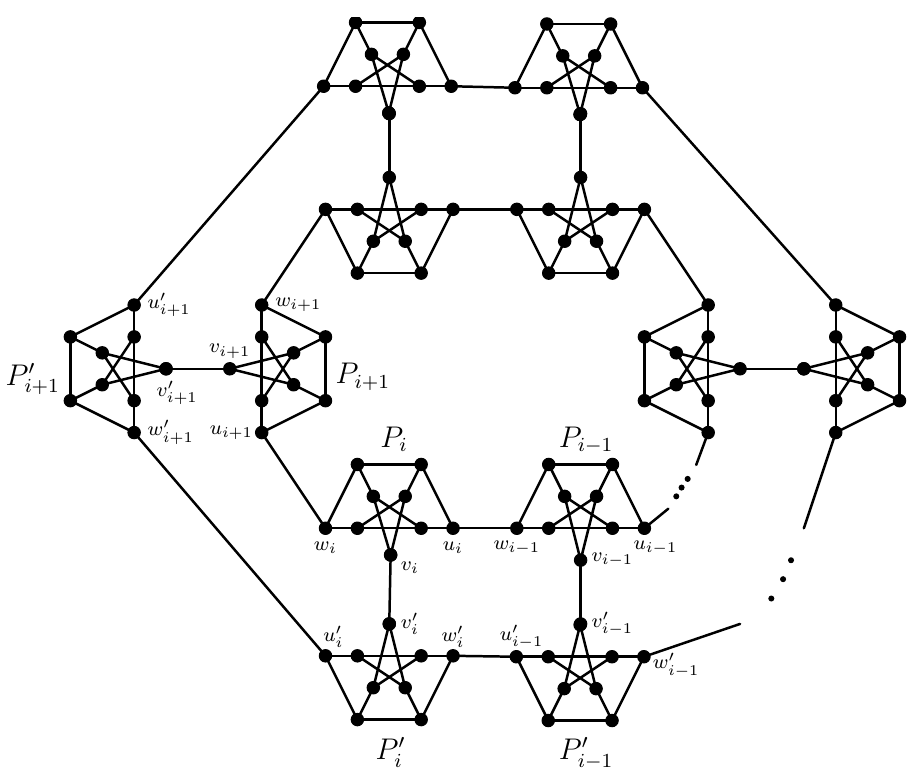
Figure 2: A 3-edge-connected cubic graph